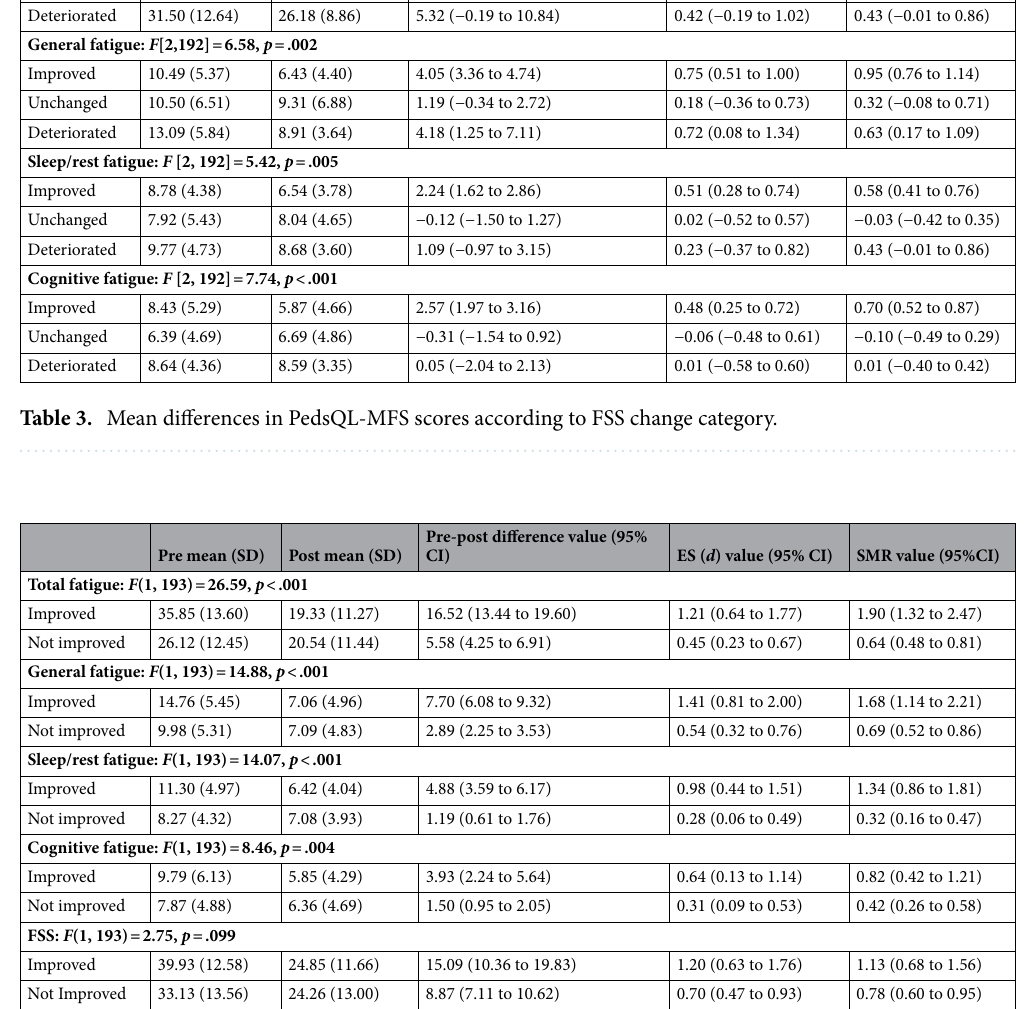
vention values on those scores. For all PedsQL-MFS scales the SRM for reduction in fatigue symptoms in the “improved” group were larger than the small to moderate effect size reductions in the “not improved” group (confidence intervals do not overlap). For each PedsQL-MFS scale, post-intervention scores were significantly lower in the “improved” CES-D change group than the “not improved” group when adjusting for pre-intervention values. By comparison, the corresponding difference in FSS post-intervention scores approached but did not reach statistical significance. Using BMI change as an anchor, 27 participants (13.6%) made a 5% or greater reduction in BMI (“improved”), with 171 (86.4%) achieving less BMI reduction (“unchanged”). There was no significant increase in weight.